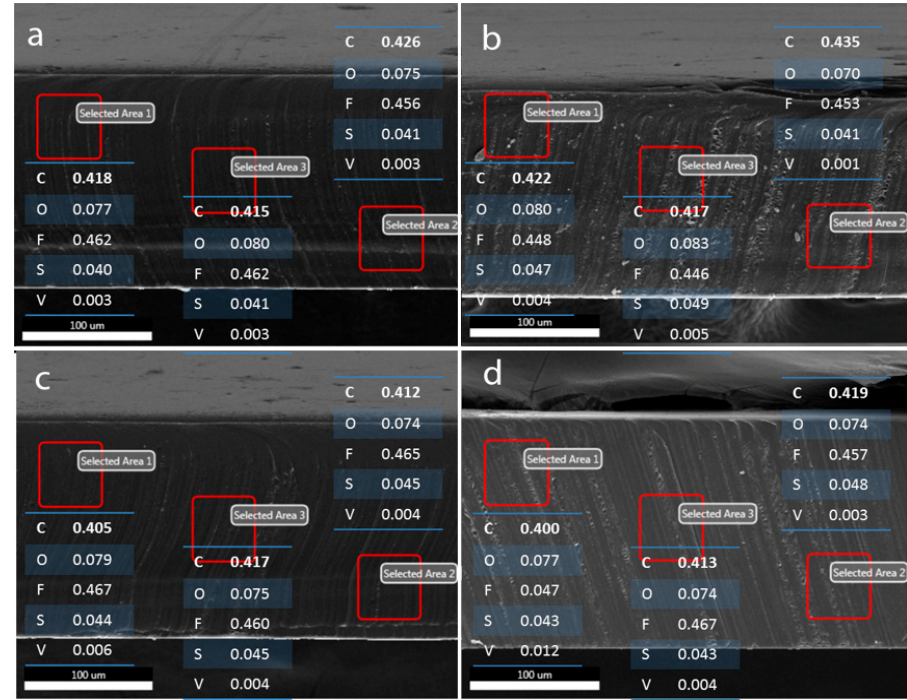
Figure 6. Results of elemental survey by EDS point analysis at various depths of the Nafion-117 membrane after being equilibrated in different vanadium ion solutions: ( a ) V 2+ , ( b ) V 3+ , ( c ) VO 2+ , and ( d ) VO 2 + solution in 2 M H 2 SO 4 ,